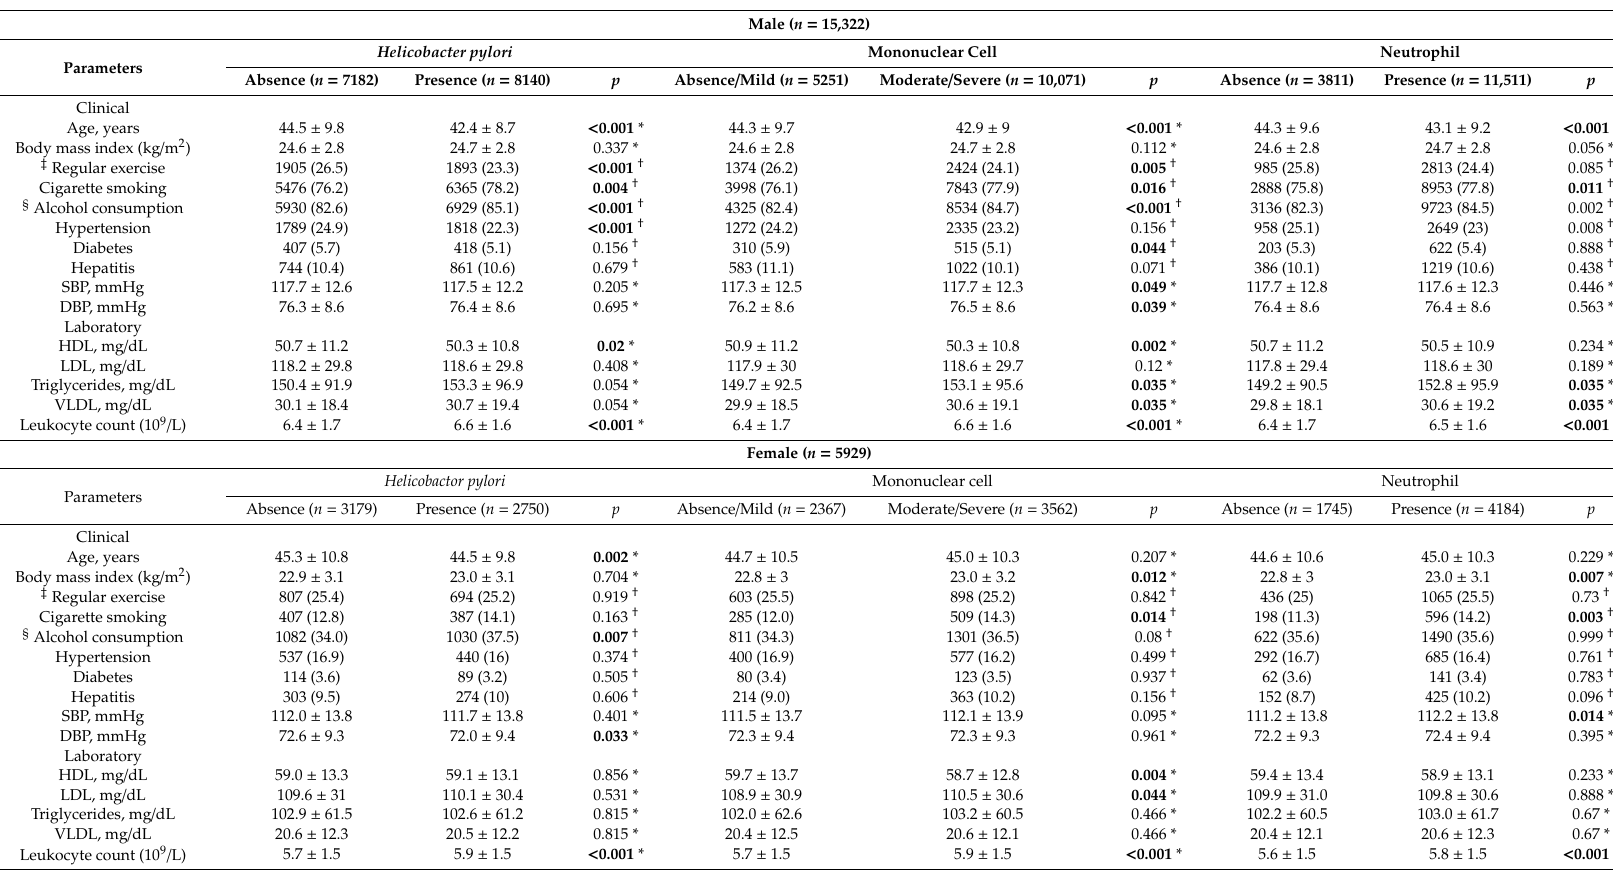
Table 2. Comparison of clinicolaboratory parameters according to Helicobacter pylori , mononuclear cells and neutrophils in the group of 15,322 males and the group of 5929 females using updated Sydney